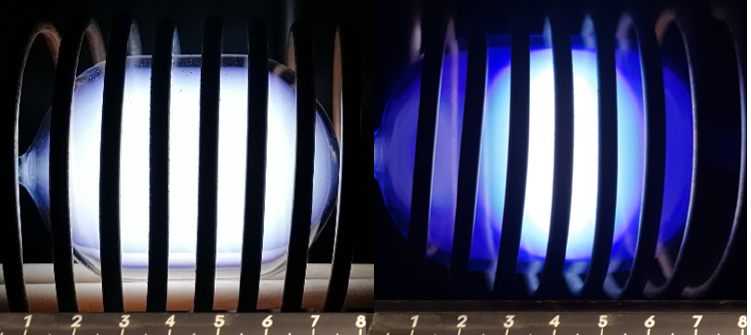
Figure 5. Comparison of the plasma distribution of pure gas- to halide-filled lamp systems at 400W input power. Left : Xe-filled lamp system. Right : Xe-I 2 -filled lamp